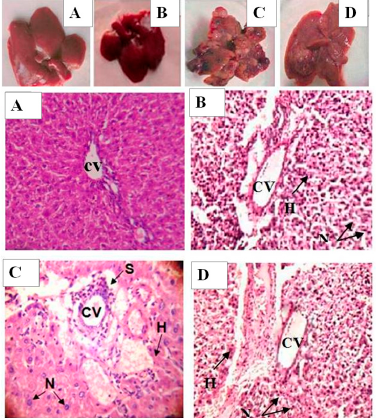
Figure 4. Histological analysis of liver tissue by hematoxylin-eosin staining. ( A ) Normal rats; ( B ) 1,3-BPMU alone; ( C ) tumor control; ( D ) DEN + 1,3-BPMU rats. Sinusoids (S), nucleus (N), central vein (CV) and hepatocyte (H).